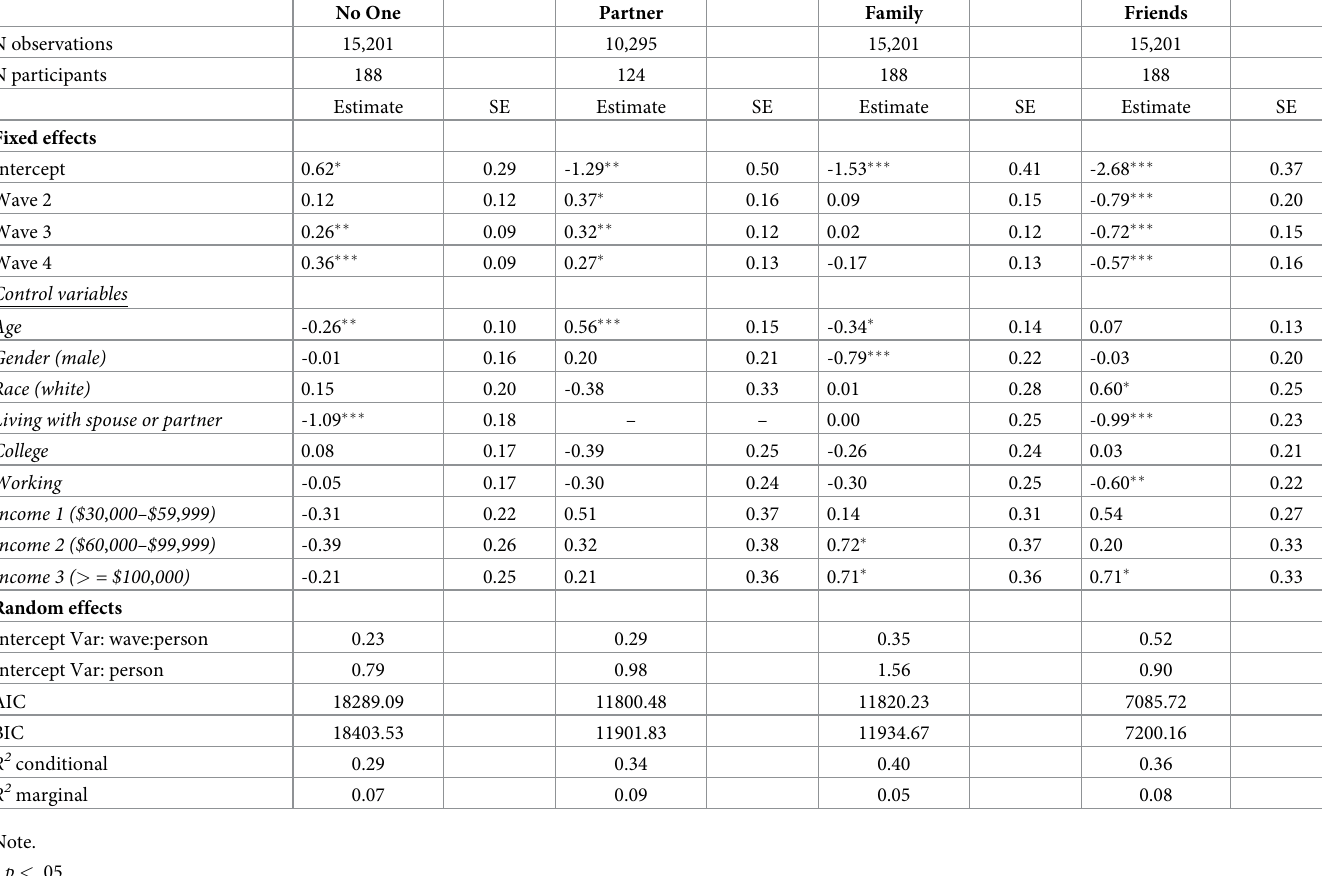
Table 2. Multilevel models with wave and demographic variables predicting the log odds of social